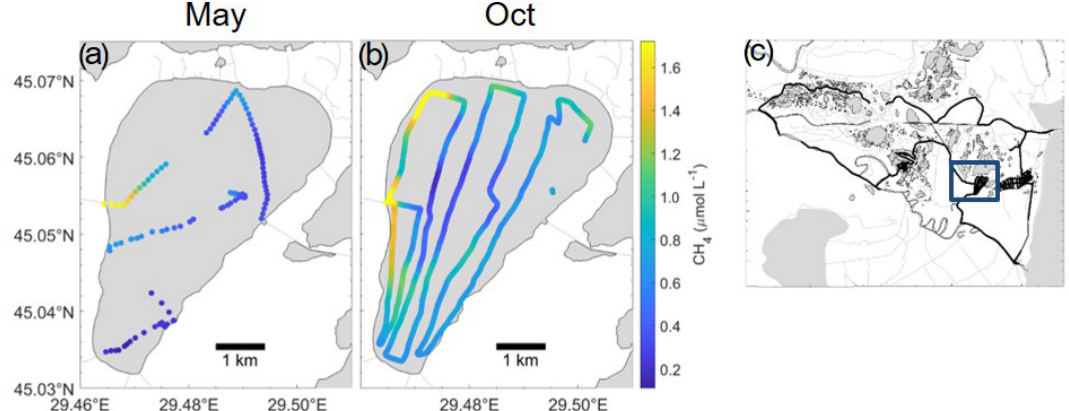
Figure 6. Spatial variability of CH 4 (µmolL − 1 ) over Lake Puiu during May (a) and October (b) from transect mapping completed over the course of a day. (c) Location of Lake Puiu within the transect throughout the Danube Delta. Channel influence can be observed closer to the edges of the lake from one direction, with concentrations reducing closer to the middle of the